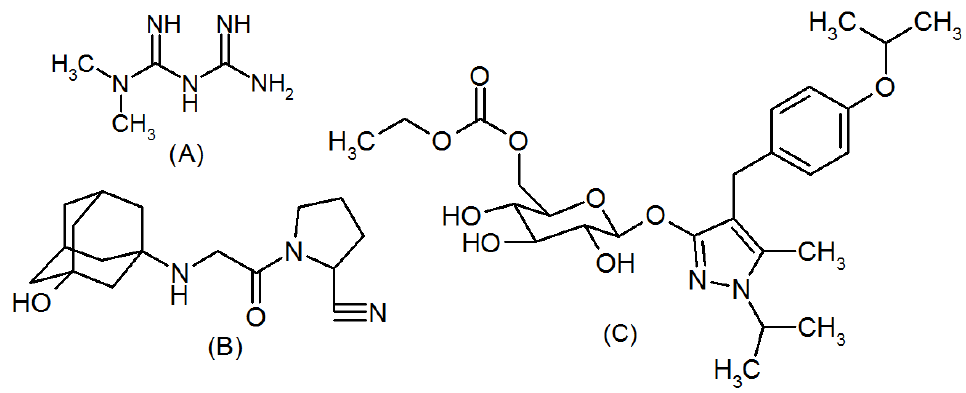
Figure 1. Chemical structures of metformin ( A ), vildagliptin ( B ), and remogliflozin ( C ).